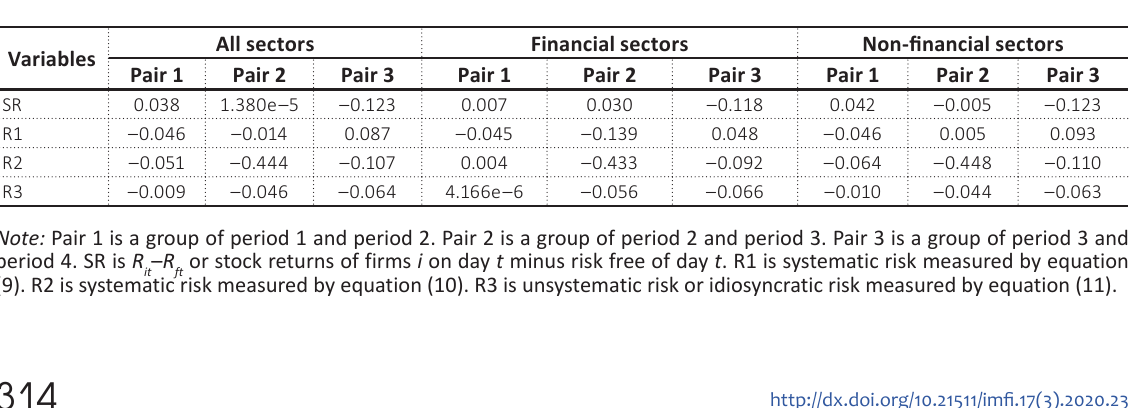
Table 5. Effect size